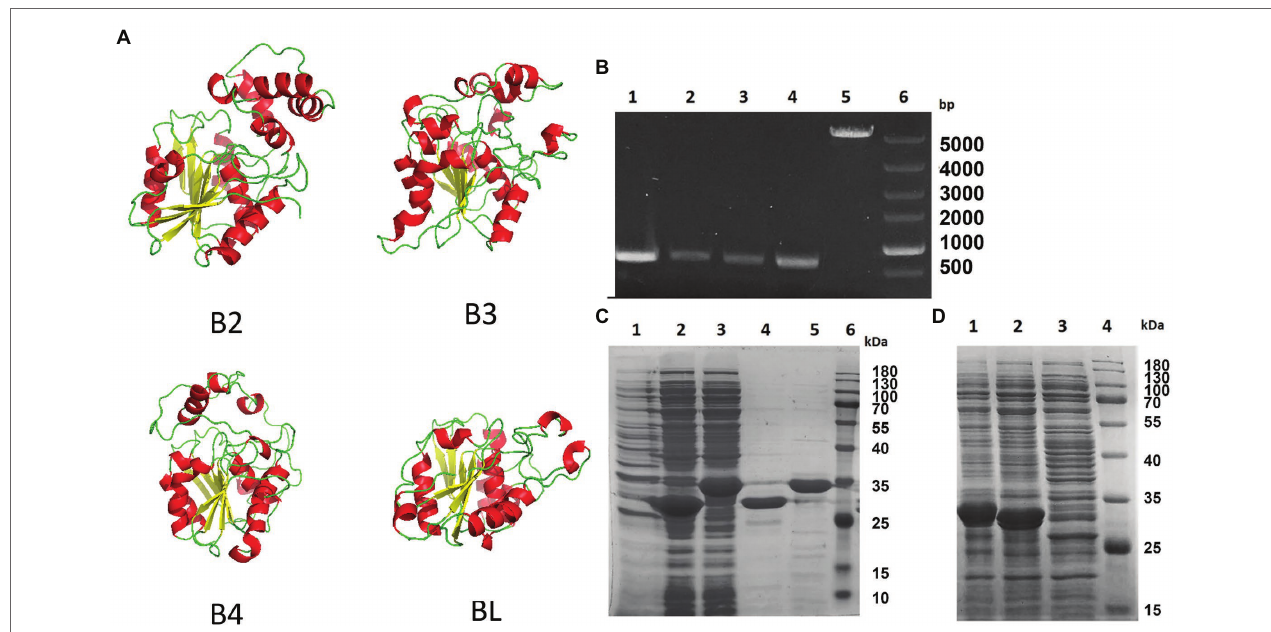
FIGURE 2 | Homology model and expression of four Bifidobacterium esterases. (A) Homology model of the four esterases, B2, B3, B4, and BL, generated by SWISS-MODEL. (B) Agarose gel electrophoresis image showing the PCR-amplified products of four esterase genes from Bifidobacterium breve and Bifidobacterium longum . Lane 1, bb2 ; lane 2, bb3 ; lane 3, bb4 ; lane 4, bl ; lane 5, pET-28a; and lane 6, supercoiled DNA marker. (C) SDS-PAGE analysis of two proteins, B2 and B3, from B. breve after being expressed in Escherichia coli BL21. Lane 1, total protein from the lysate of E. coli transformed with pET-28a; lane 2, total protein of E. coli lysate containing esterase B2; lane 3, total protein of E. coli lysate containing esterase B3; lane 4, esterase B2 after purification; lane 5, esterase B3 after purification; and lane 6, prestained protein molecular weight marker. (D) SDS-PAGE analysis of two esterases, B4 and BL, from B. breve and B. longum in E. coli BL21. Lane 1, total protein of E. coli lysate containing esterase B4; lane 2, total protein of E. coli lysate containing esterase BL; lane 3, total protein of E. coli lysate transformed with pET-28a; and lane 4, prestained protein molecular weight